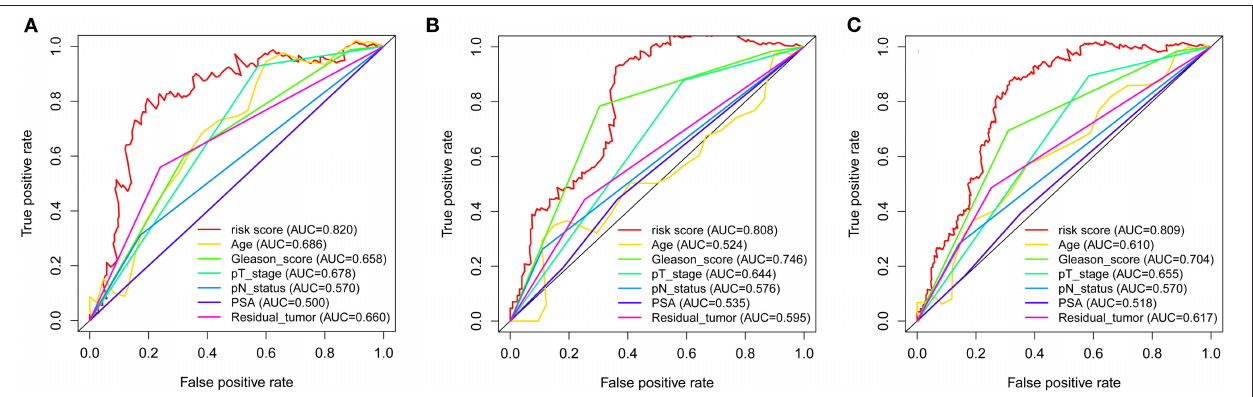
FIGURE 4 | ROC curves compare the prognostic power between the prognostic signature and clinicopathological features. (A) Training set. (B) Test set. (C) Entire set. P -values indicate the area under curve (AUC) at 5 years for multi-protein-based signature verse the AUC at 5 years for other features.